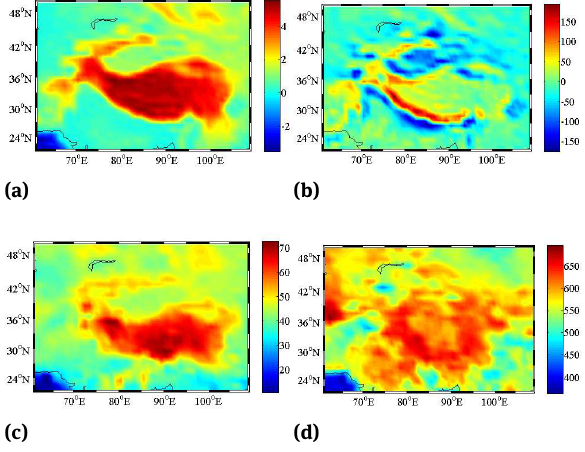
Figure 3: a) TB heights [km], b) ∆ g EGM08 [mGal], c) Seismic Moho model of CRUST1.0 [km] and d) laterally-variable density contrast derived from CRUST1.0 [kgm −3